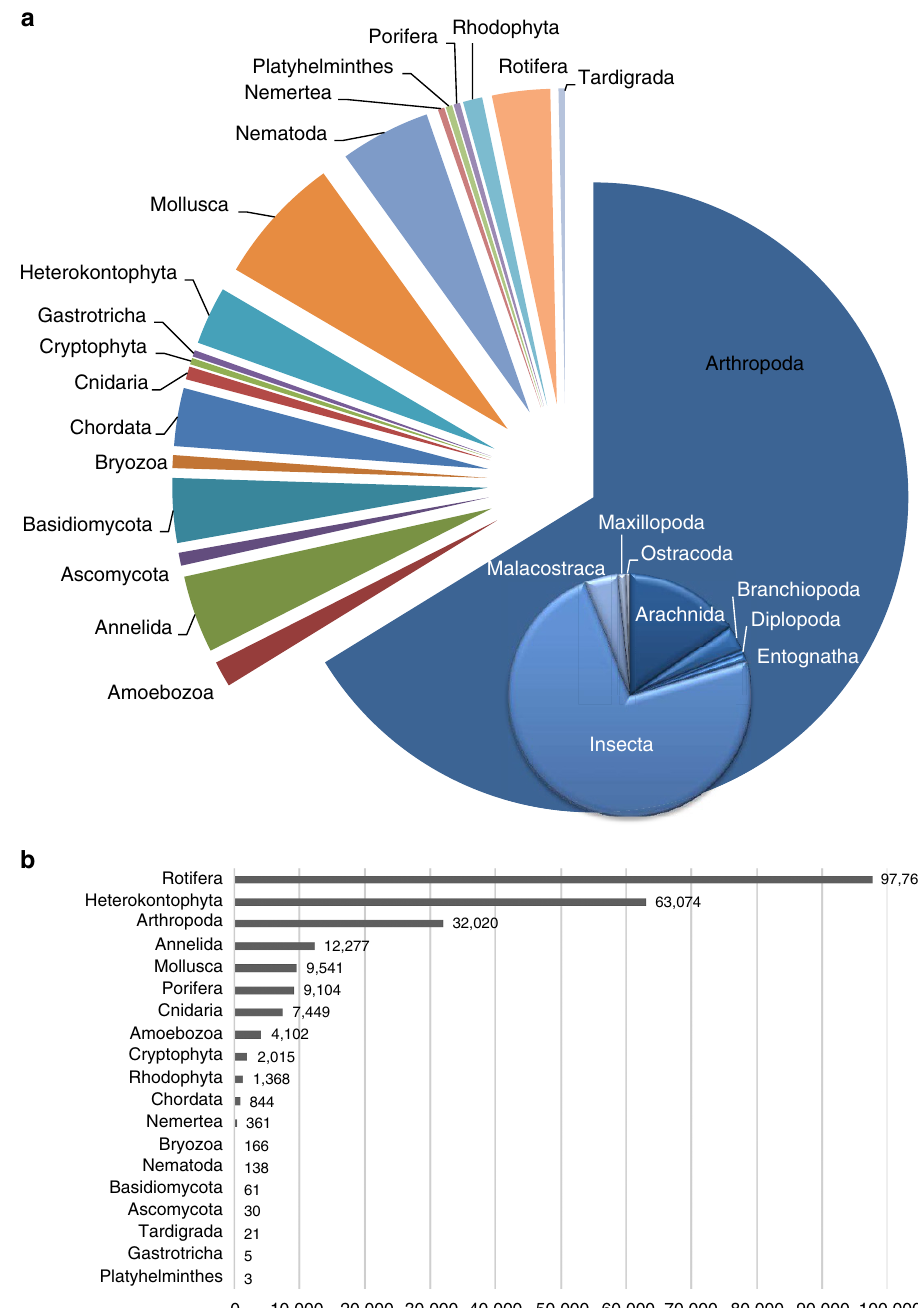
Figure 2 | Total eukaryotic diversity detected from the river Glatt using environmental DNA metabarcoding. ( a ) The number of families per phylum ( N ¼ 296) sampled and confirmed as known to be present in Switzerland or known from all four neighbouring countries (Austria, France, Germany and Italy). The inset further breaks the most abundant phylum (Arthropoda) into the number of families sampled by class ( N ¼ 196). ( b ) Grey bars depict the number of sequences receiving a taxonomic identification at the family level for each